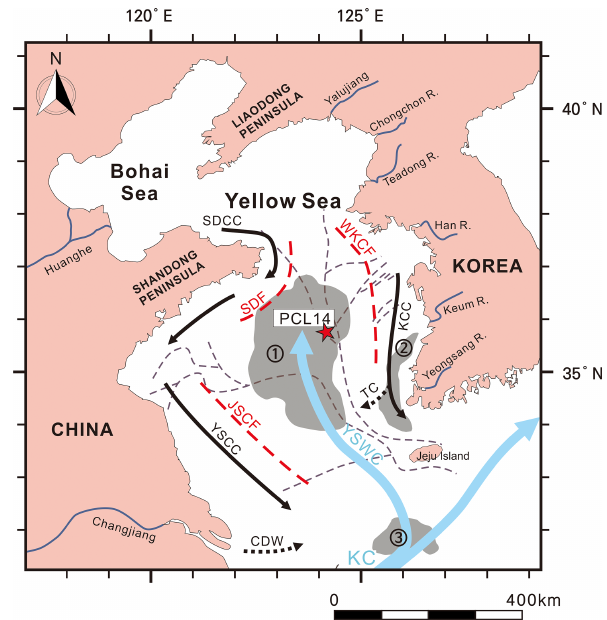
Figure 1. Schematic map showing the location of core 11YS- PCL14 and the surface circulation in the Yellow Sea (modified from Li et al., 2014a; Wang et al., 2014). The dotted gray lines indi- cate the paleo-river pathways (Yoo et al., 2016). Acronyms are de- fined as follows: (1) Central Yellow Sea Mud (CYSM), (2) South- eastern Yellow Sea Mud (SEYSM), (3) Southwestern Jeju Island Mud (SWCIM), Kuroshio Current (KC), Yellow Sea Warm Current (YSWC), Shandong Coastal Current (SDCC), Yellow Sea Coastal Current (YSCC), Korean Coastal Current (KCC), Shandong Front (SDF), Jiangsu Coastal Front (JSCF), Western Korean Coastal Front